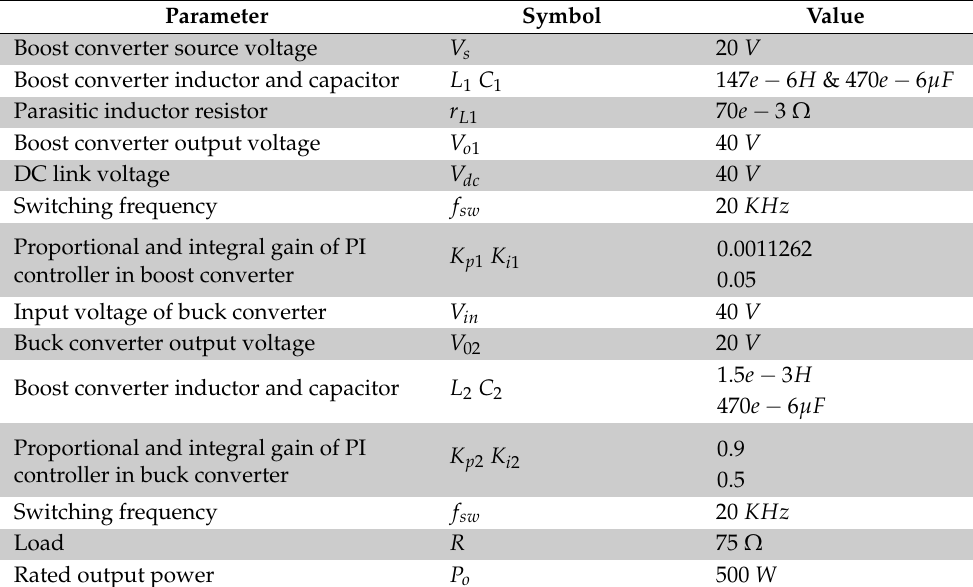
Table A1. The parameters used for the experimental